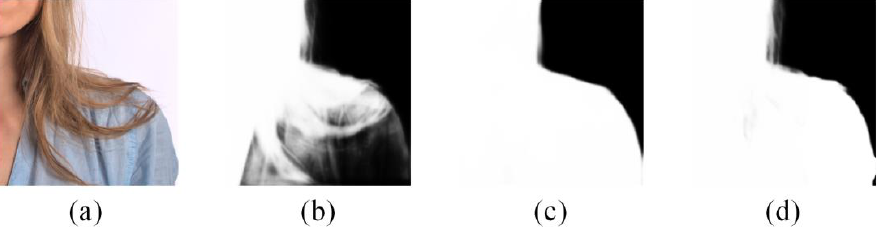
Figure 4. Effect of contour sharpness refinement network placed on different layers: ( a ) original image; ( b ) placed on layers 5 and 6; ( c ) placed on layers 1 and 2; and ( d ) placed on layers 3 and 4.